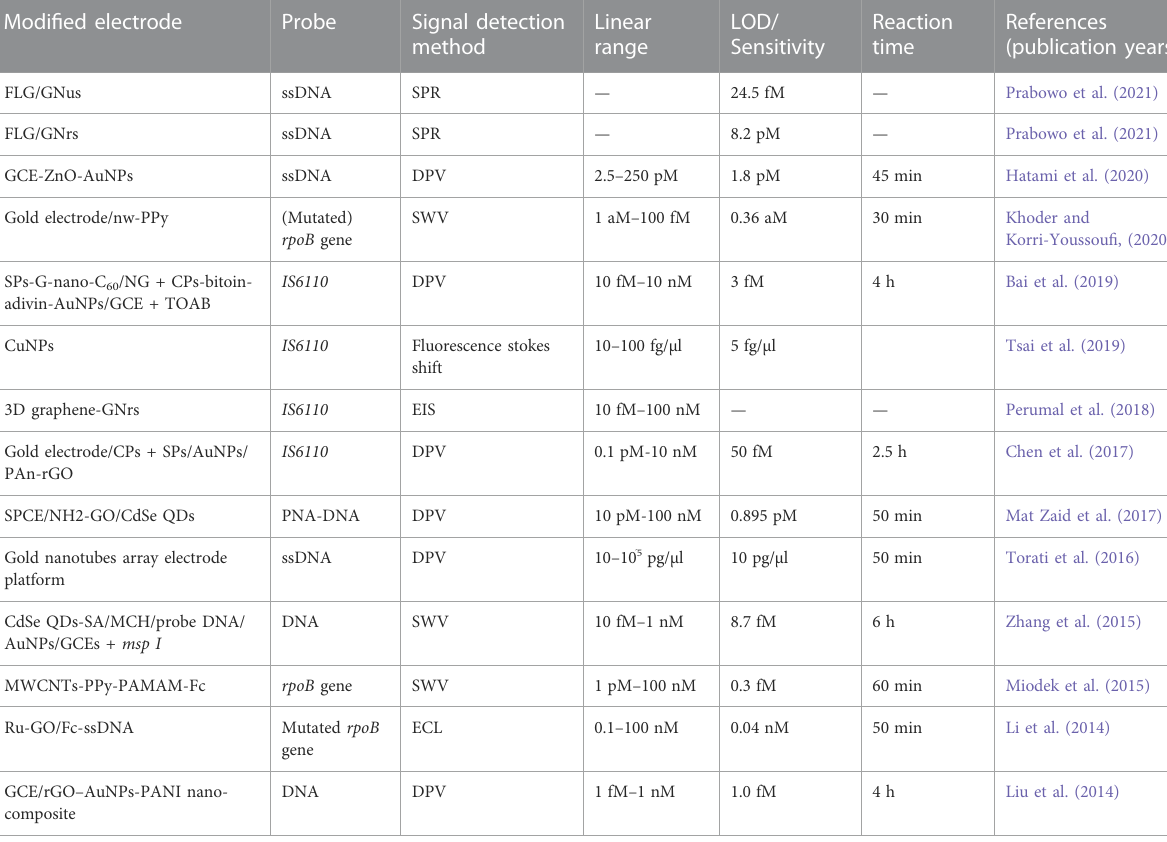
TABLE 1 Comparison of the performance of different kinds of DNA